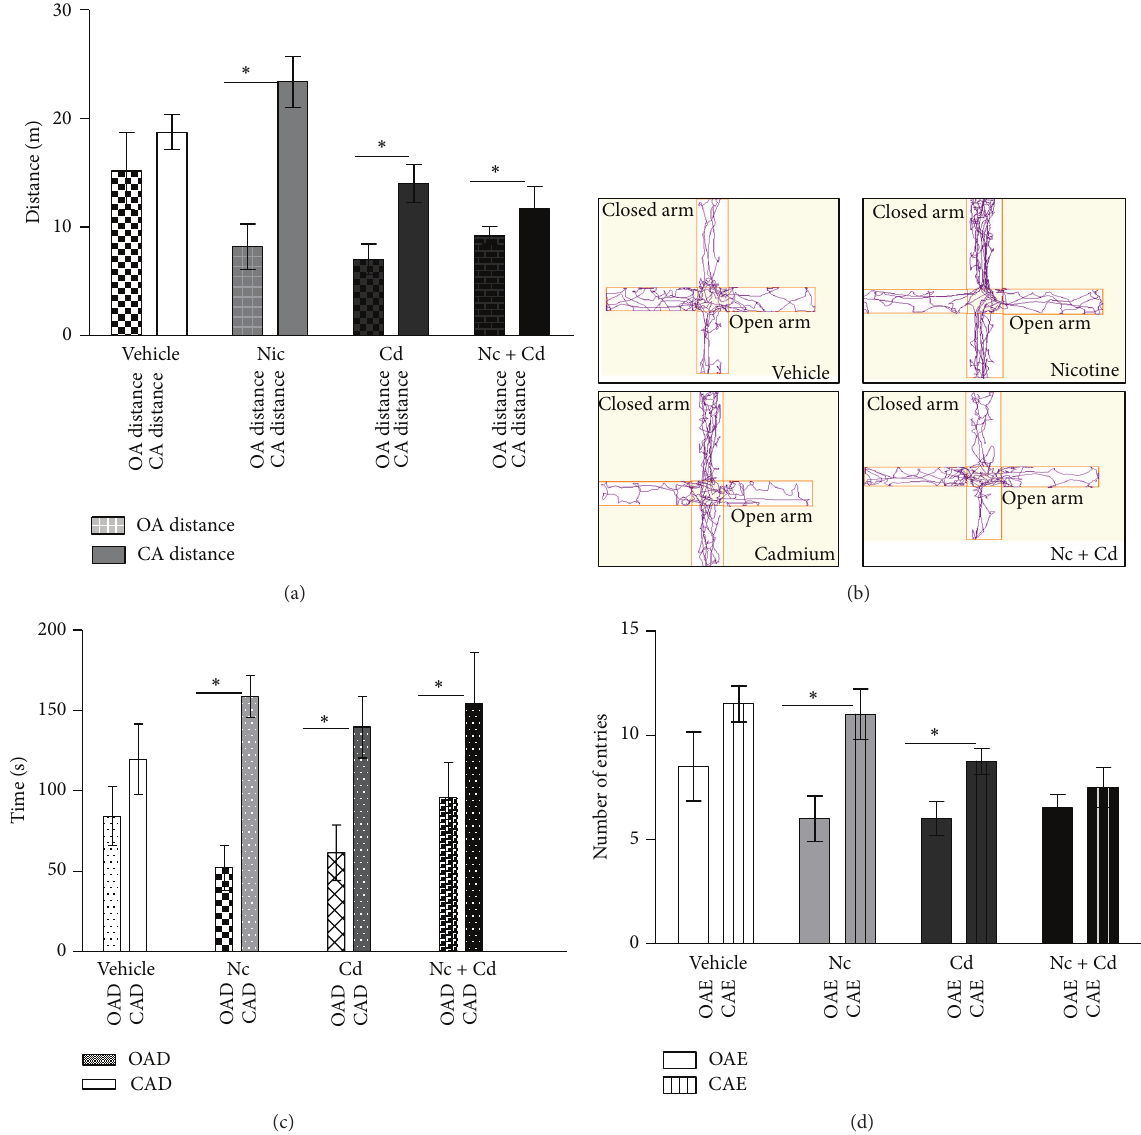
Figure 6: (a, b) The average distance travelled in meters in elevated plus maze. (a) The open arm distance (checked bars) and closed arm distance (plain bars) for the treatment groups were compared versus the control. Nicotine treated female mice showed a significance in the distance covered in the open arm when compared with the control ( 𝑃 < 0.05 ). In furtherance, cadmium treated mice recorded a decrease in total exploration distance when compared with the nicotine treated group ( 𝑃 < 0.05 ). Anxiety linked behaviors were observed in the nicotine treatment as they explored the closed arm more than the open arm. Also, the cadmium and nicotine-cadmium treated groups showed a significant decline in exploration time and explored the closed arm more than the open arm ( statistical significance : ∗ 𝑃 < 0.05 ). (b) Track plots of the mice during the 4 minutes exploration in EPM using Any-Maze software to demonstrate the open and closed arm distances. (c and d) Elevated plus maze open/closed arm entries and duration. (c) Close arm (CAD::stripes) and open arm (OAD::plain) durations for the treatment groups versus the control. Increased CAD was observed in the nicotine, cadmium, and nicotine-cadmium treatment group ( 𝑃 < 0.05 ), thus depicting increased anxiety in these animals. (d) Bar chart showing the frequency of close arm (CAE) and open arm (OAE) entries for the treatment groups and control. A significant difference ( 𝑃 < 0.05 ) was observed between the CAE and OAE in the nicotine and cadmium treated groups ( ∗ 𝑃 < 0.05 ). No significance was seen when the OAE and CAE were compared for the combined nicotine-cadmium treatment group ( statistical significance : ∗ 𝑃 < 0.05